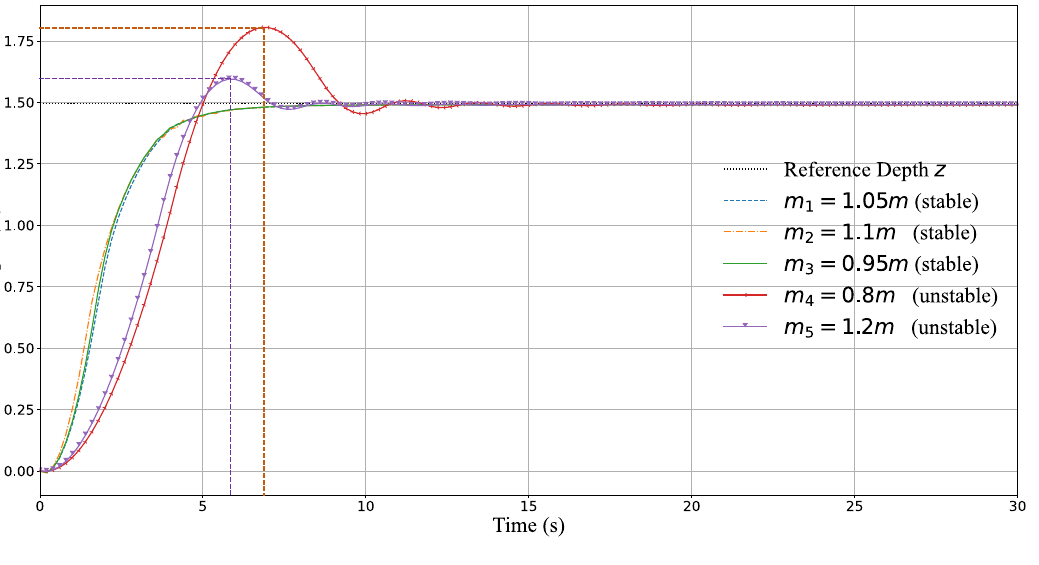
Figure 11. Depth robust step response of MR-TD3. The controller is robust to different masses of the AUV to maintain a consistent depth performance.